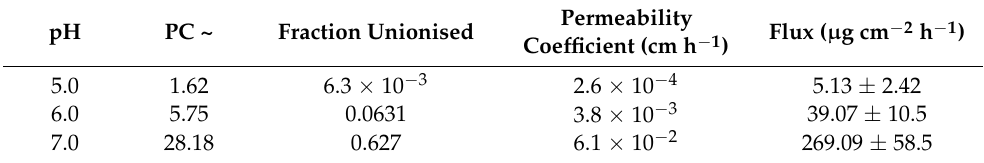
Table 3. PC, unionised fractions, permeability coefficient and flux (across human skin) for benzy- damine HCl at different donor pH values. For flux experiments, 2% benzydamine hydrochloride was applied in buffer solutions ( n = 6, values represent the mean ± S.D.) Adapted with permission